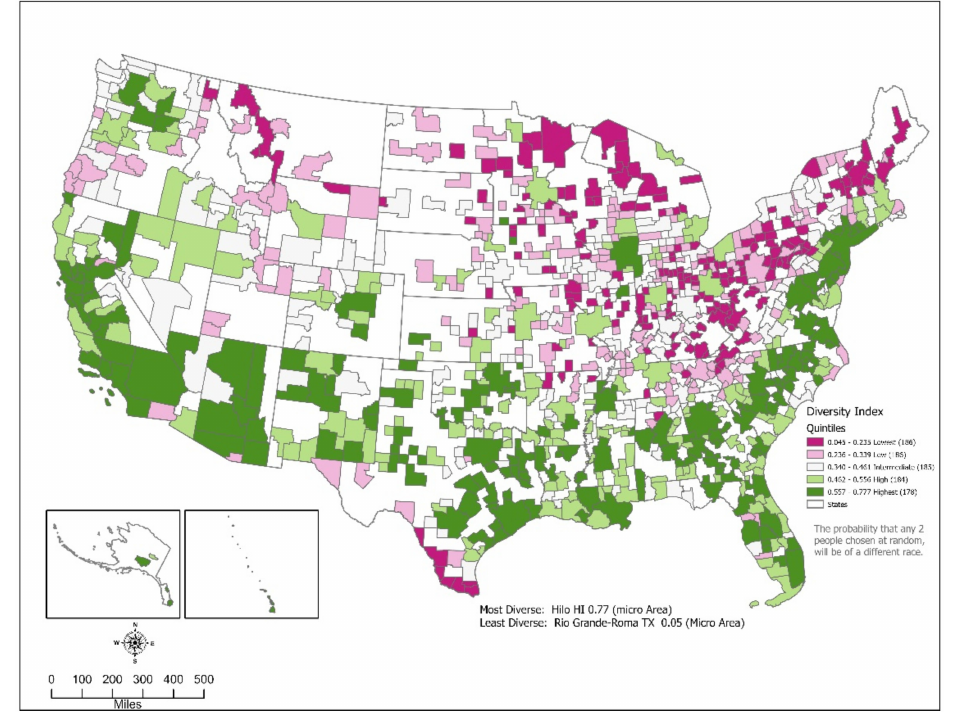
Figure 9. Metropolitan and Micropolitan Area Racial Diversity Indexes, 2020.